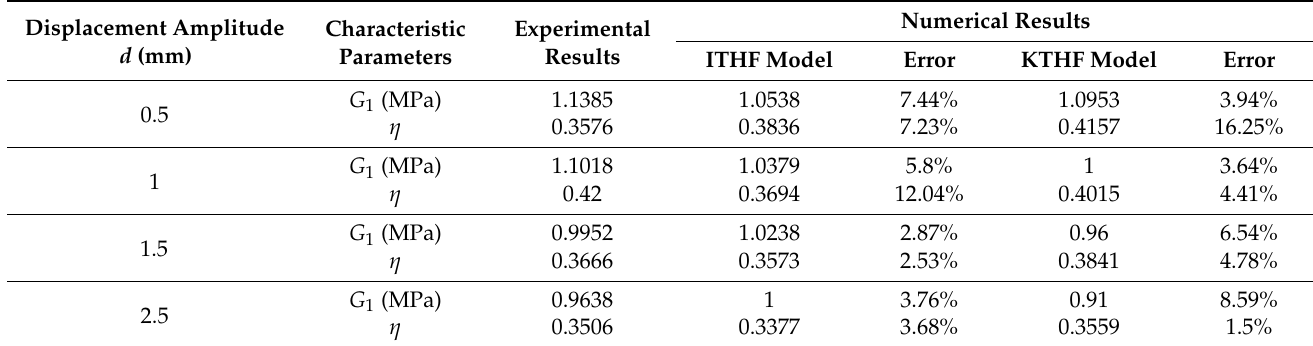
Table 6. The comparisons of the ITHF model and KTHF model when f = 1.0 Hz.